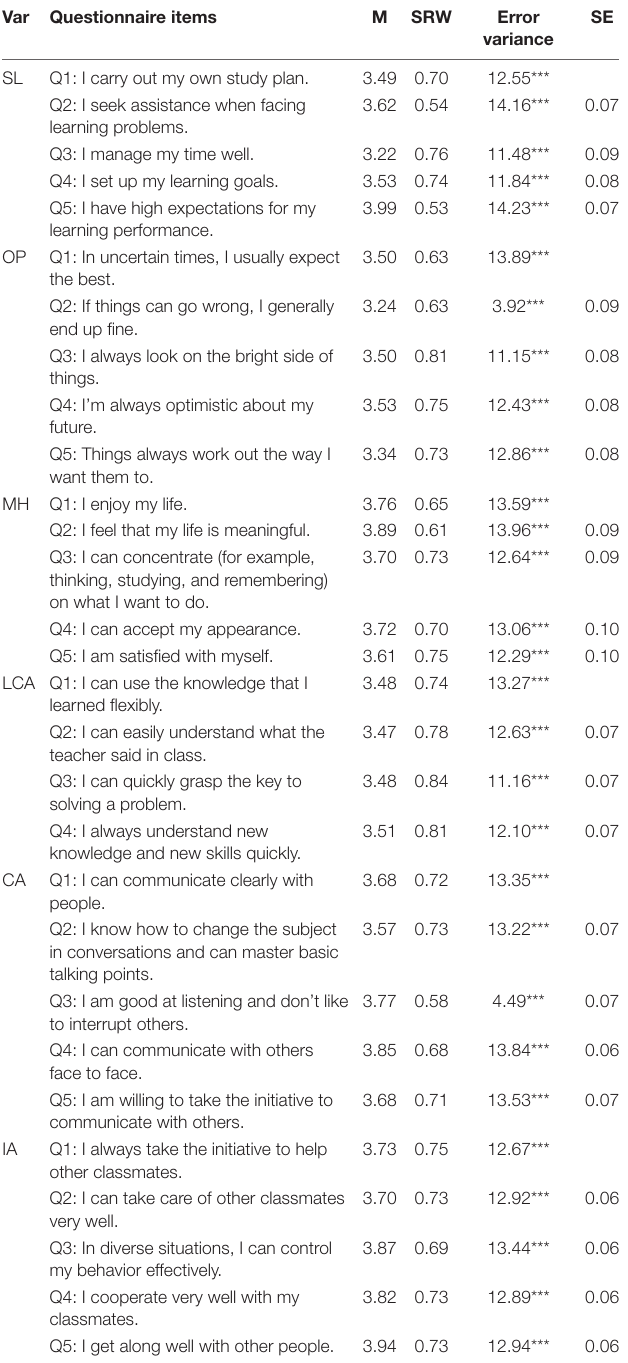
TABLE 2 | Questionnaire items employed in this research. Var Questionnaire items M SRW Error